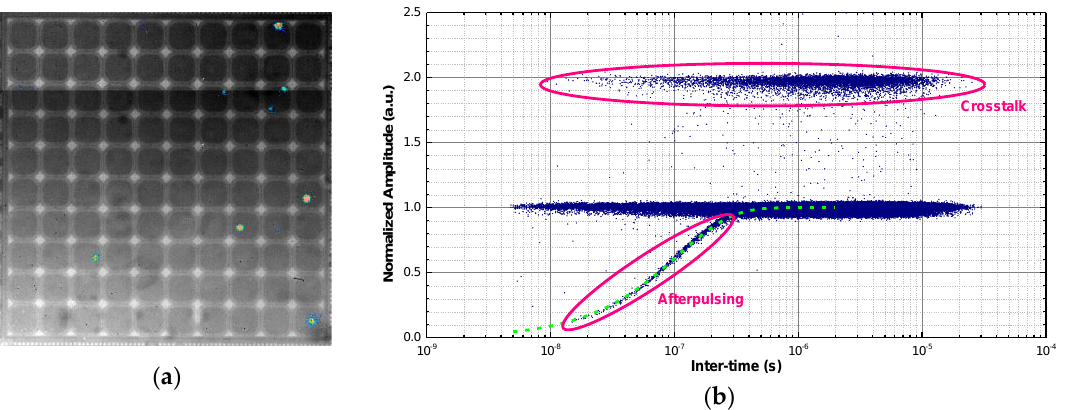
Figure 4. ( a ) Near-infrared emission from the back side of a shallow SiPM chip at V EX = 8 V, as acquired by an InGaAs camera; ( b ) Scatter plot of timing and amplitude of secondary pulses for a shallow SiPM at 5 V of excess bias. The pulse amplitude is normalized to the average height of a single cell signal. The exponential fitting of the recovery transient is also reported.